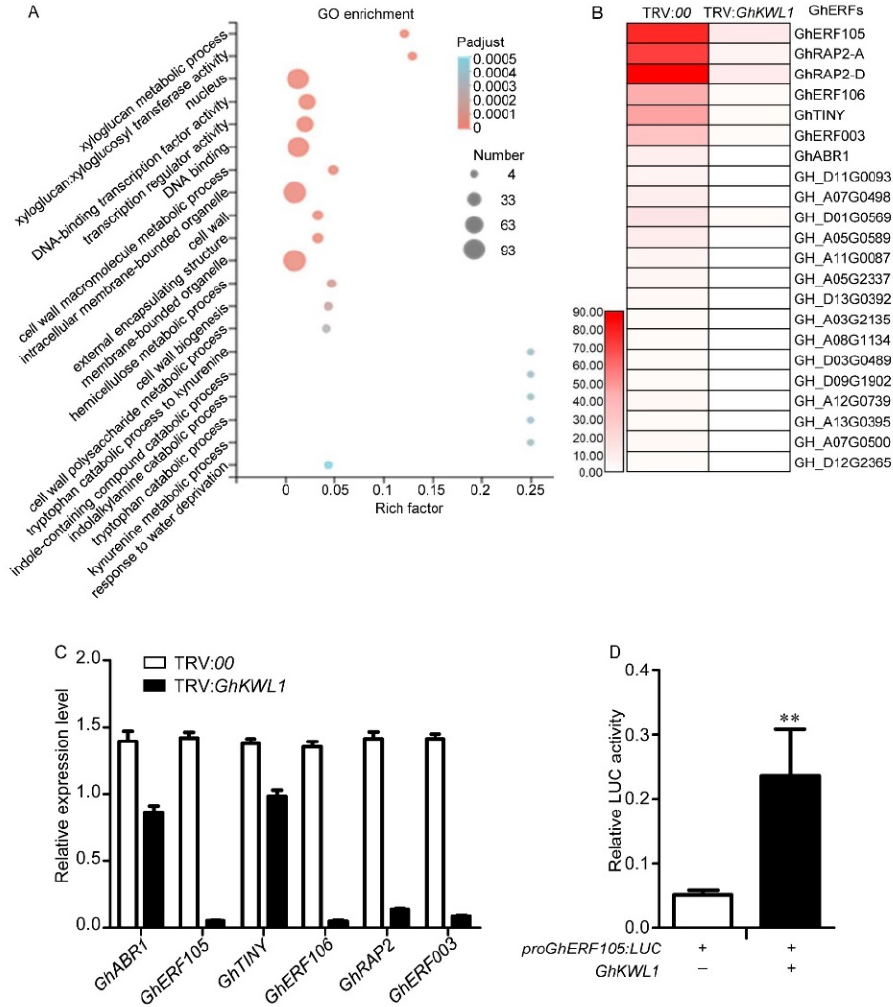
Figure 3. GhKWL1 plays a positive role in upregulating the expression of GhERF genes. ( A ) Gene ontology (GO) enrichment of downregulated genes in GhKWL1 -silenced plants (TRV: GhKWL1 ) vs. the control (TRV: 00 ). The x -axis represents the Rich Factor. The greater the value, the greater the enrichment degree. The y -axis represents various GO terms. The bubble size indicates the number of differential genes in each GO term. The color code indicates the P adjust value. If the p adjust value < 0.05, the pathway was defined as a significantly enriched GO term. ( B ) Heat map of the relative expression level of GhERF genes (determined by RNA-seq reads) in GhKWL1 -silenced plants and the control (TRV: 00 ). Total RNAs were extracted from leaves of cotton plants after 2 weeks of virus-induced gene silencing of GhKWL1 and used for RNA-seq analysis. ( C ) Relative expression levels of GhERF genes in GhKWL1 - silenced (TRV: GhKWL1 ) plants and the control (TRV: 00 ). Total RNAs were extracted from leaves of cotton plants after 2 weeks of virus-induced gene silencing of GhKWL1 . The relative level was determined by quantitative RT-PCR. GhUBQ7 served as the reference gene. GhERF105 represents GH_A03G0725; GhRAP2-A represents GH_A05G1425; GhRAP2-D represents GH_D05G1440; GhERF106 represents GH_D07G0504; GhTINY represents GH_D10G1125; GhERF003 represents GH_D05G0585; GhABR1 represents GH_A02G1617. ( D ) The promoter of GhERF105 was activated by the expression of GhKWL1 . The luciferase activity was determined by the LUC/REN ratio. Asterisks indicate statistical significance as determined by Student’s t -test (** p <